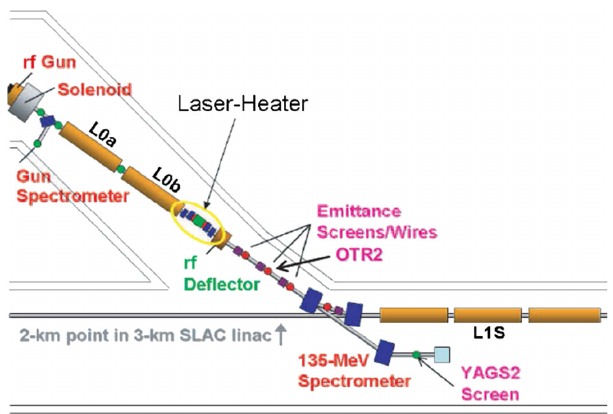
FIG. 16. Application C: the LCLS injector layout showing laser heater, transverse rf deflector OTR/YAG screens wire scanners, and spectrometers,